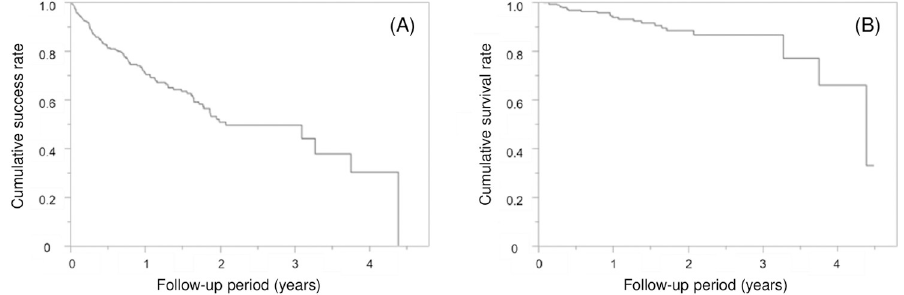
Fig 4. Kaplan–Meier curves showing the (A) cumulative success rate and (B) cumulative survival rate of CAD/CAM composite crowns.